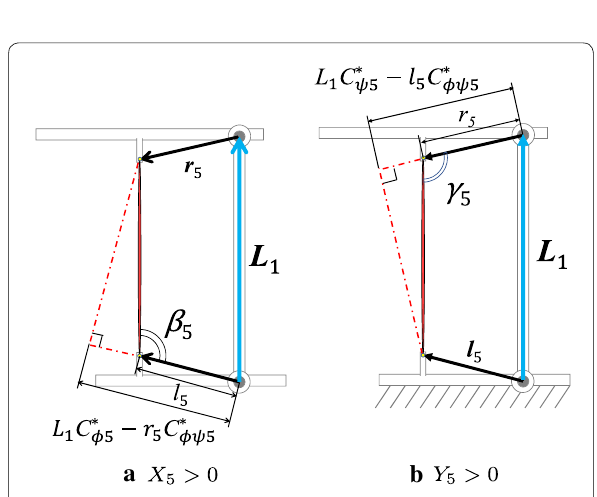
Fig. 9 Geometric conditions of the 5th biarticular muscle